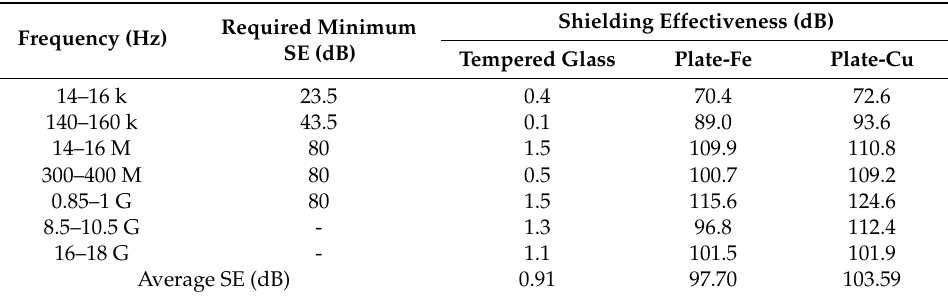
Table 3. SE test results of specimens